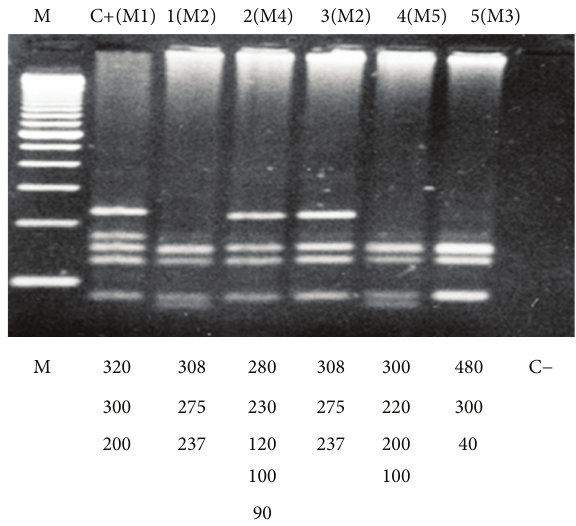
F 3: Digestion patterns with the enzyme MboI found in some analyzed samples. Electrophoresis in 2